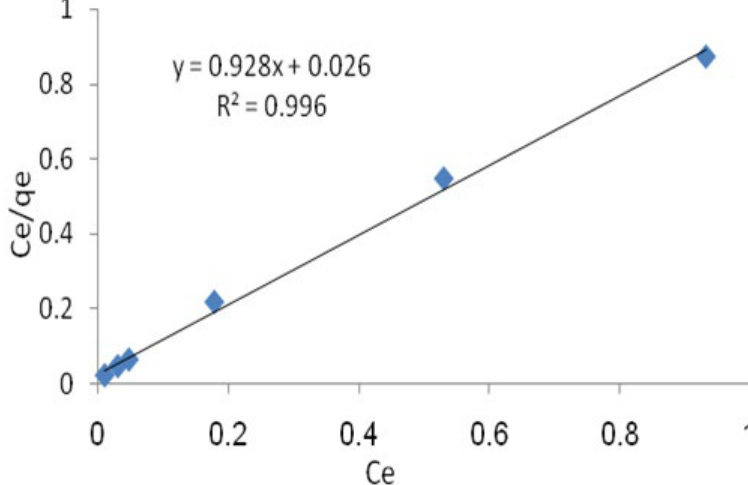
Fig. 5. Linear curve of Langmuir adsorption isotherm for As adsorption using the prepared adsorbent..